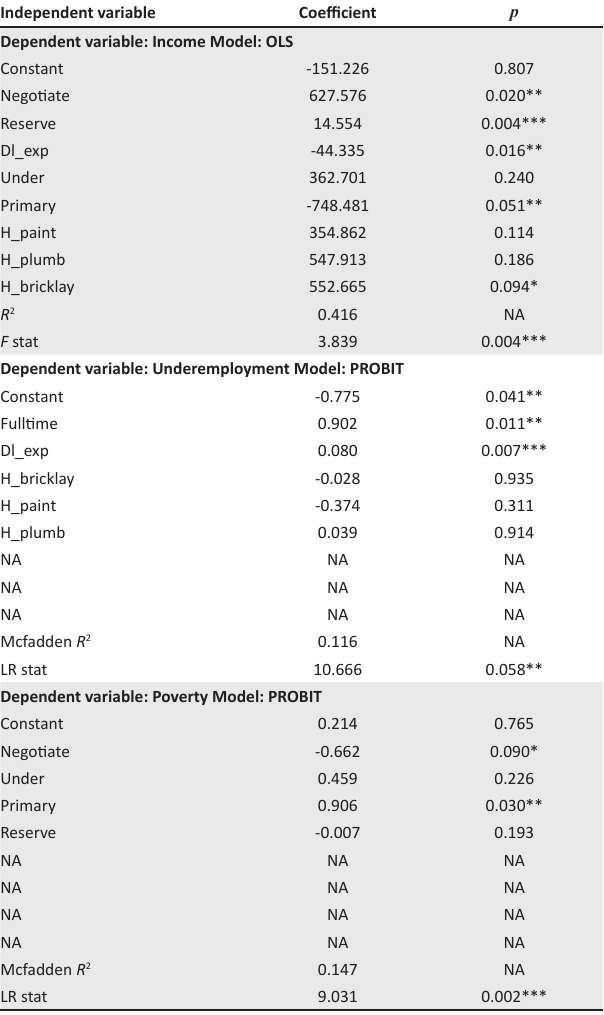
TABLE 4: Day labouring: Income effects, determinants of underemployment and likelihood of increased poverty. Independent variable